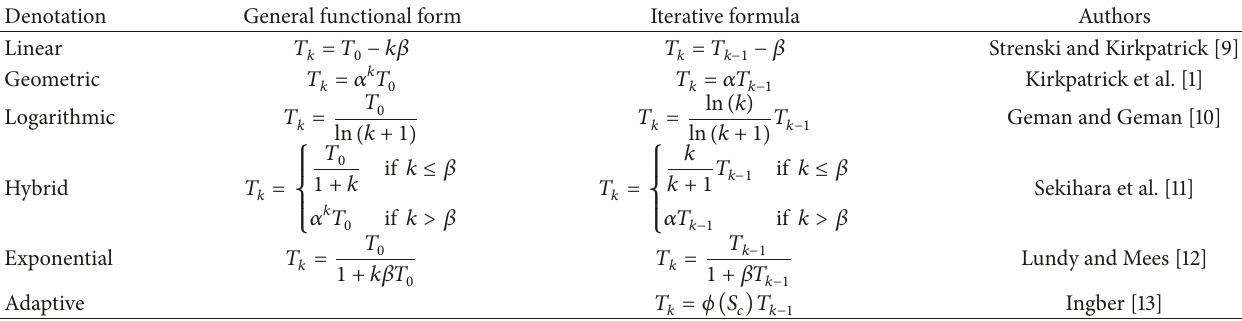
Table 1: Summary of classical cooling